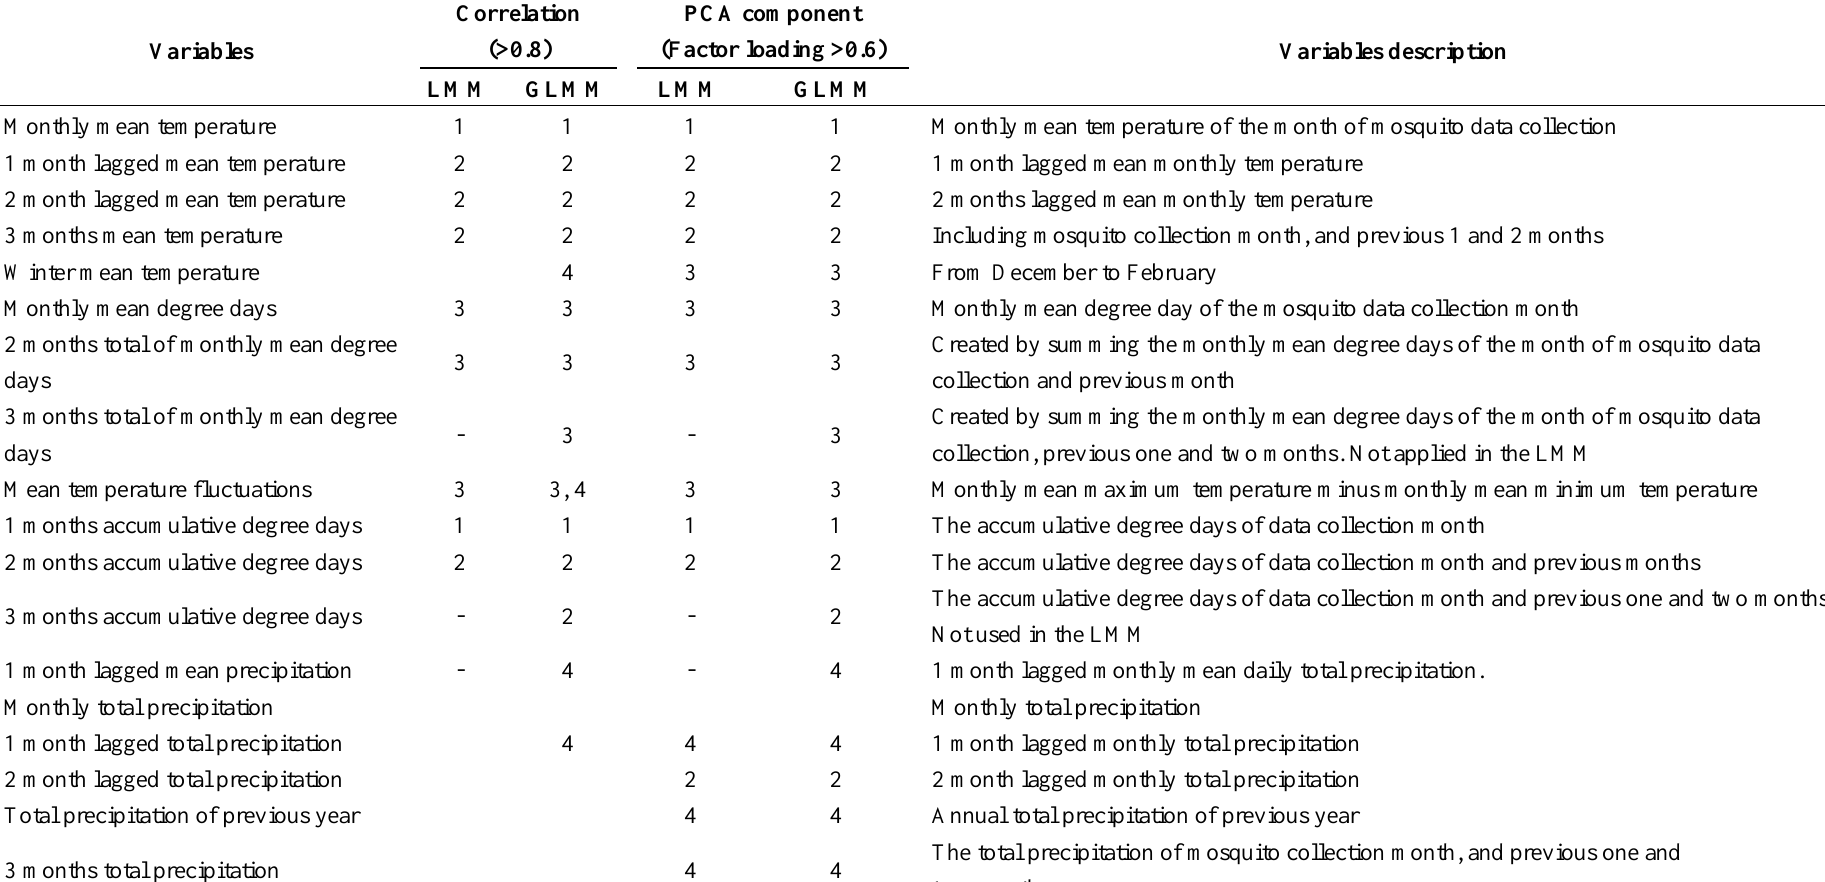
Table 1. Descriptions of variables used in both Cx. tarsalis abundance and infection rate models and relationships between explanatory variables based on the Pearson correlation and principal component analysis. Variables with the same arabic number indicated that the Pearson correlations are larger than 0.8 or have factor loading larger than 0.6 in each component of principal component analysis.